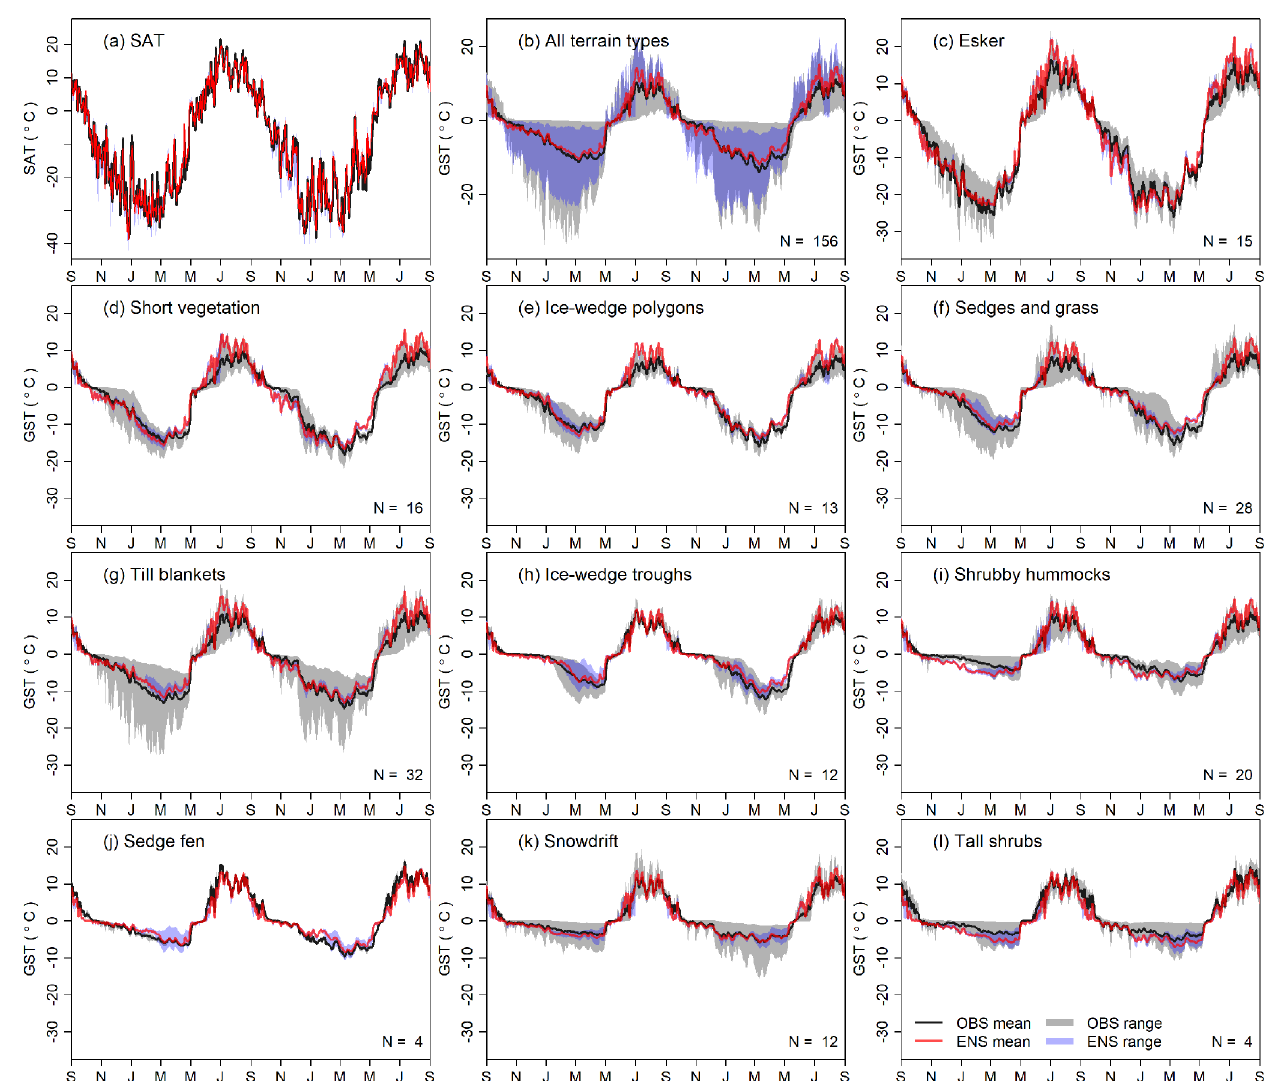
Figure 8. Comparison of ensemble (ENS) simulation results with observations (OBS) for (a) daily near-surface air temperature (SAT); (b) daily ground-surface temperature (GST) for all the sites and; (c–l) daily GST for individual terrain classes. The date range for all figures is September 2015 to September